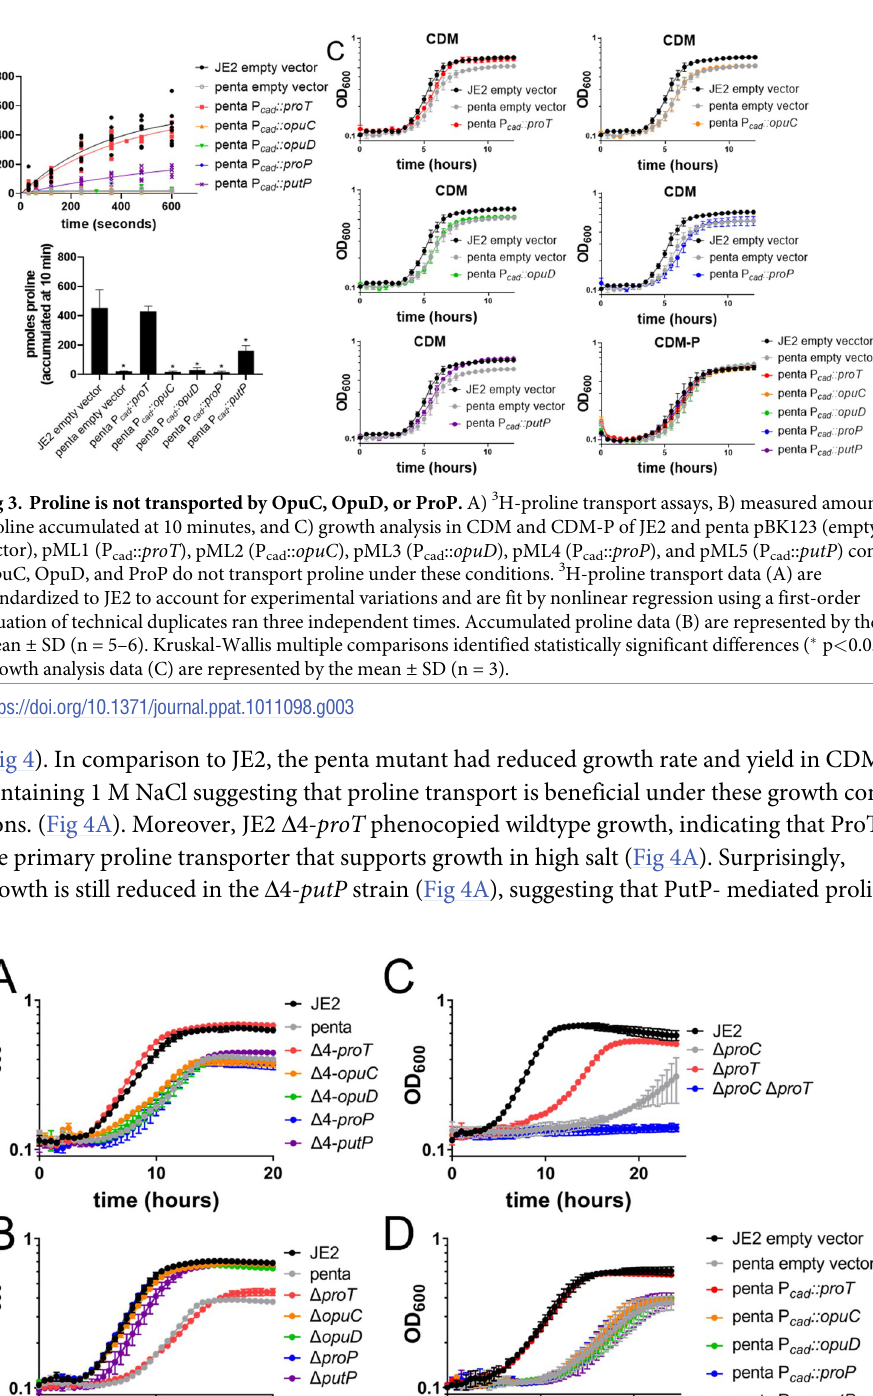
Fig 4. ProT is the primary proline transporter in the presence of high salt. Growth analysis of the following strains in CDM supplemented with 1 M NaCl: A) JE2, penta, Δ 4- proT , Δ 4- opuC , Δ 4- opuD , Δ 4- proP , and Δ 4- putP B) JE2, penta, Δ proT , Δ opuC , Δ opuD , Δ proP , and Δ putP C) JE2, Δ proC , Δ proT , and Δ proT Δ proC D) JE2 empty vector, penta empty vector, penta